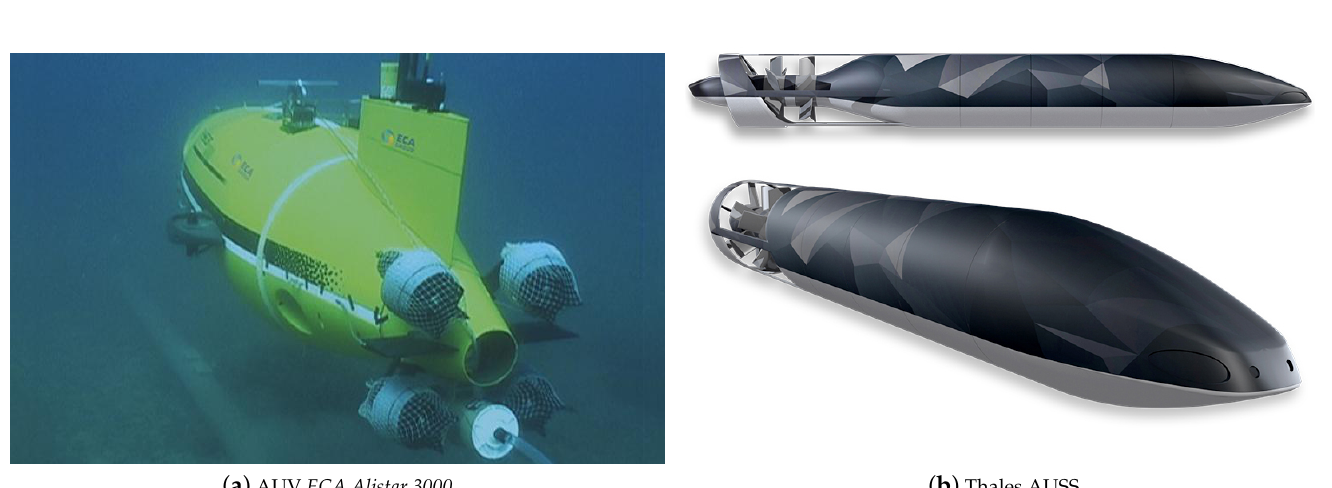
Figure 3. Examples of robots with vectorial thrust [22,25].